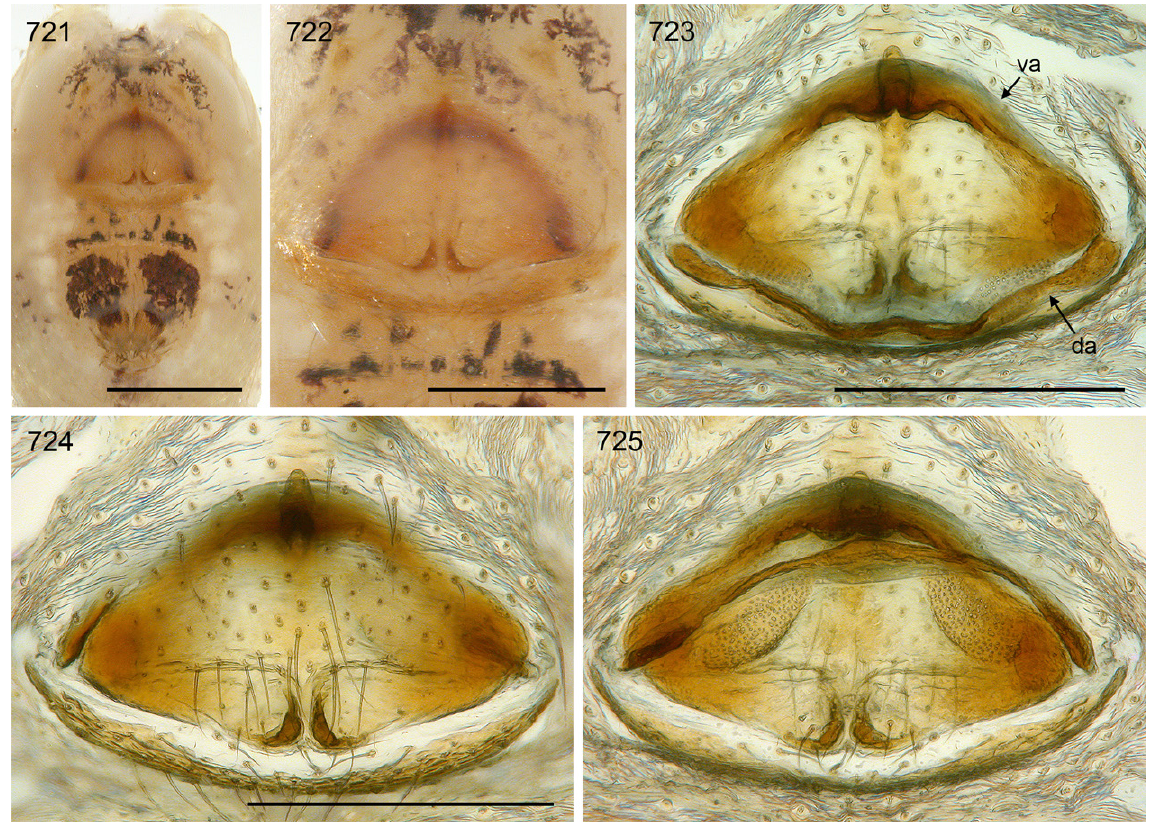
Figs 721–725. Crossopriza miskin sp. nov.; female from Oman, wadi near Fasah (ZFMK Ar 22447). 721–722 . Abdomen and epigynum, ventral views. 723–725 . Cleared female genitalia, dorsal view with dorsal arc tilted backwards, ventral view, and regular dorsal view. Scale bars: 721 = 0.5 mm; 722–725 = 0.3